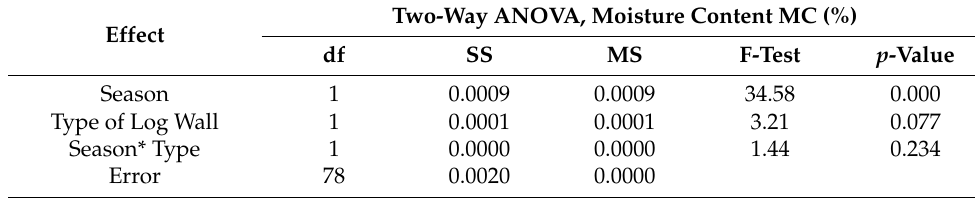
Table 3. Results of ANOVA for the insulation STEICO Universal width 22 mm.